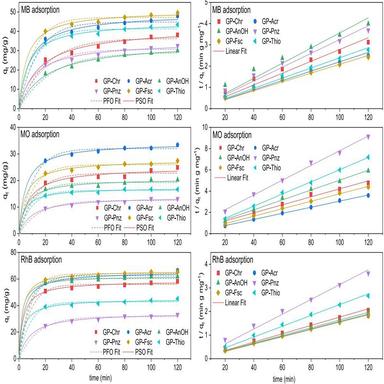
(right) Summary of adsorption capabilities of MO, RhB and MB dyes for GP modified samples (0.0323 g/L) studied by spectrophotometric method monitoring absorbance decreases at 464 nm (MO), 664 nm (MB) and 553 nm (RhB) over 120 min; Pseudo-first order (PFO) and pseudo-second order (PSO) non-linear fitting curves. (left) Linear adjustment of pseudo-second order kinetic model.